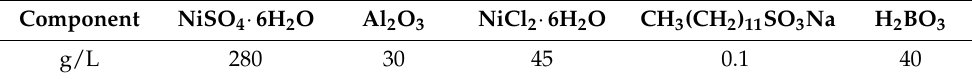
Table 1. Composition of the plating solution.